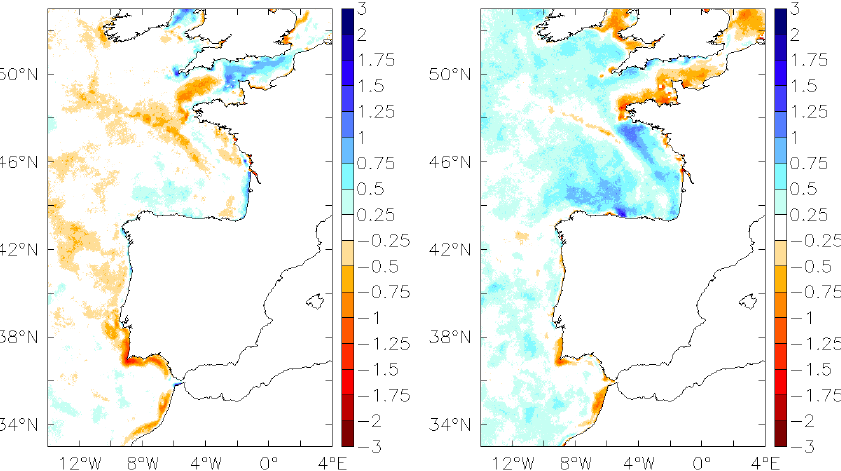
Figure 16 : (observation minus model) Sea Surface Temperature Fig. 16. (observation minus model) Sea Surface Temperature difference ( ◦ C) for the period May–June 2009 (left) for V1 system, (right) V2 difference (°C) for the period May-June 2009 (left) for V1 system, system. Observations come from CMS L3S SST. The Mediterranean Sea is masked. (right) V2 system. Observations come from CMS L3S SST. The Mediterranean Sea is masked. Table 5. RMS difference and correlation observation-model for zonal/meridional component of currents at 3m depth for the period May–June 2009 at different buoys (presented in Fig. 7). Statistics for IBI36 is calculated with 1 day filtered residual currents. Statis- tics for PSY2v3 is calculated with daily averaged currents. Best 29 of 38 scores are in